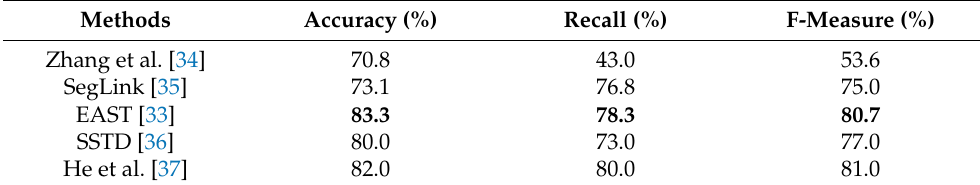
Table 6. Text detection results on ICDAR 2015 incidental text dataset.